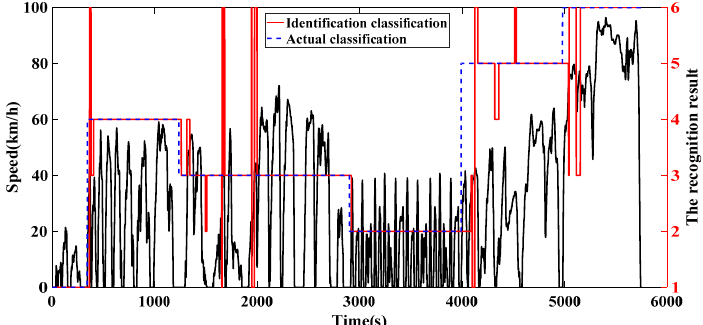
Figure 12. The recognition result of test driving condition.